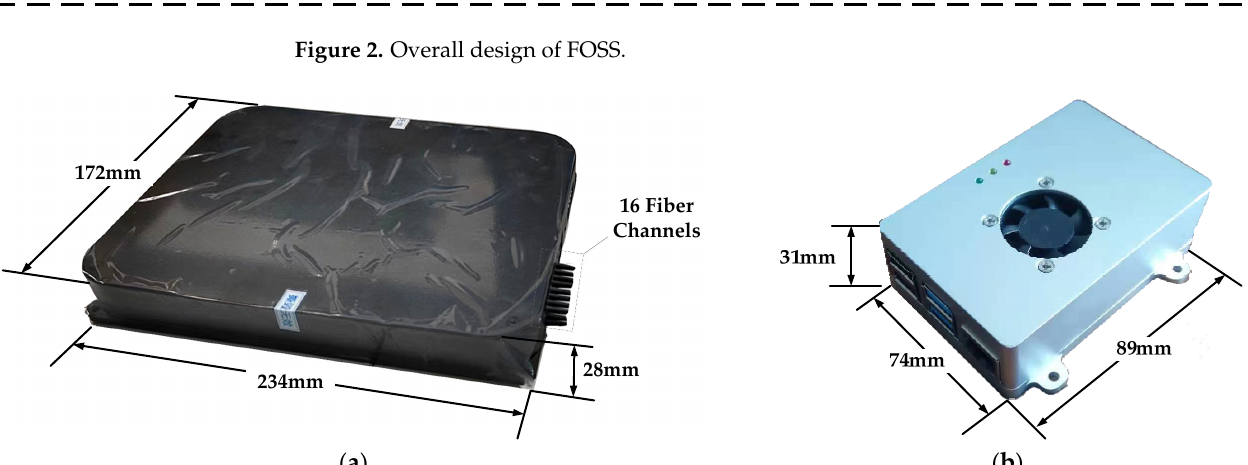
Figure 2. Overall design of FOSS.